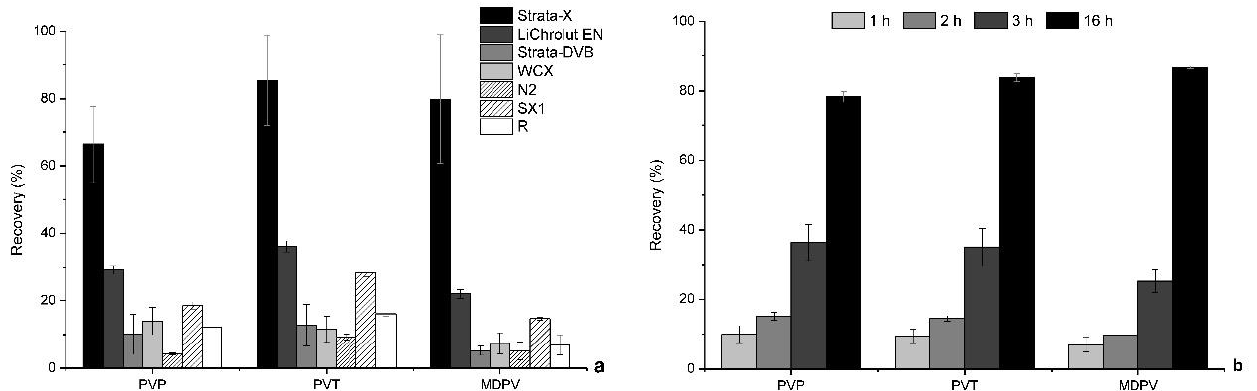
Figure 1. Effect of the sorbent selectivity ( a ) and equilibrium time ( b ) on the microextraction of the three SCs in aqueous media obtained by BA µ E- µ LD/GC-MS(SIM). The experimental conditions ( a ) consisted of the microextraction stage of 16 h (1000 rpm), pH 5.5 (25 mL), and the liquid desorption stage: MeOH (100 µ L), 30 min under sonication treatment. The experimental conditions ( b ) of microextraction with Strata-X-coated BA µ E devices at 750 rpm, pH 5.5 (25 mL), and liquid desorption stage: MIX (100 µ L) for 45 min under sonication. The error bars represent the standard deviation of three replicates.